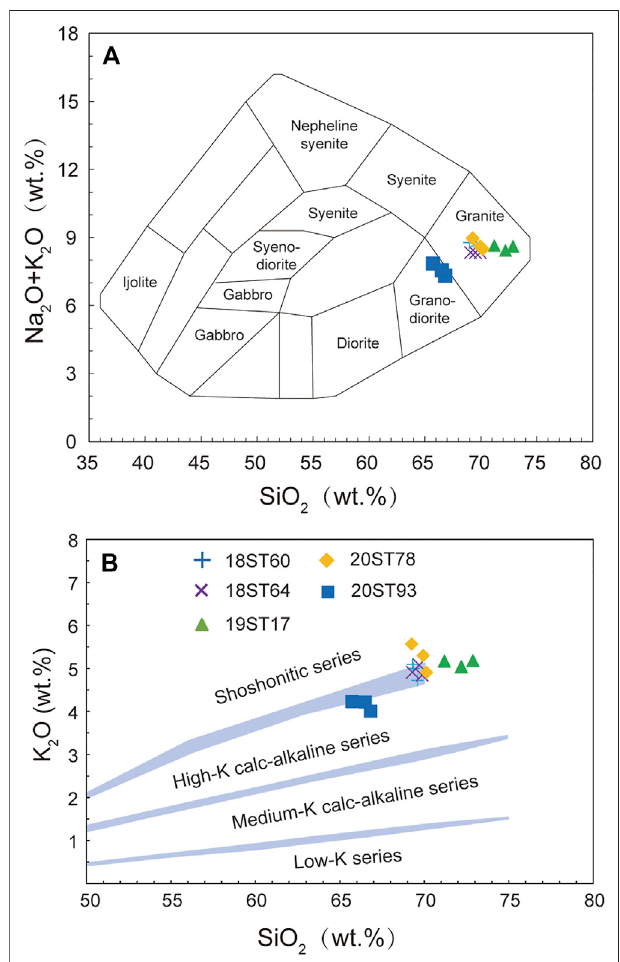
FIGURE 7 | Petrochemical classi fi cation diagrams of the Permian granitoids, and their characteristic major elements. (A) Total alkalis vs. silica diagram (after Cox et al., 1979) showing that the samples plot in the fi elds of granite and granodiorite, which is consistent with their main mineral compositions shown in Figure 3 ; (B) K 2 O (%) vs. SiO 2 (%) diagram (after PeccerilloandTaylor,1976)showingthattheinvestigatedgranitoidsbelongto the high calc-alkaline to shoshonitic